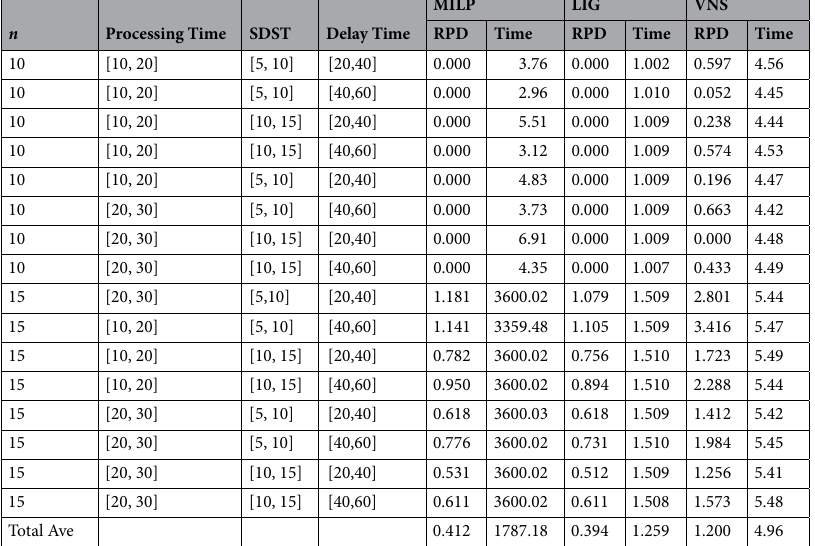
Table 7. Average RPD s (%) and running time for small-scale instances.